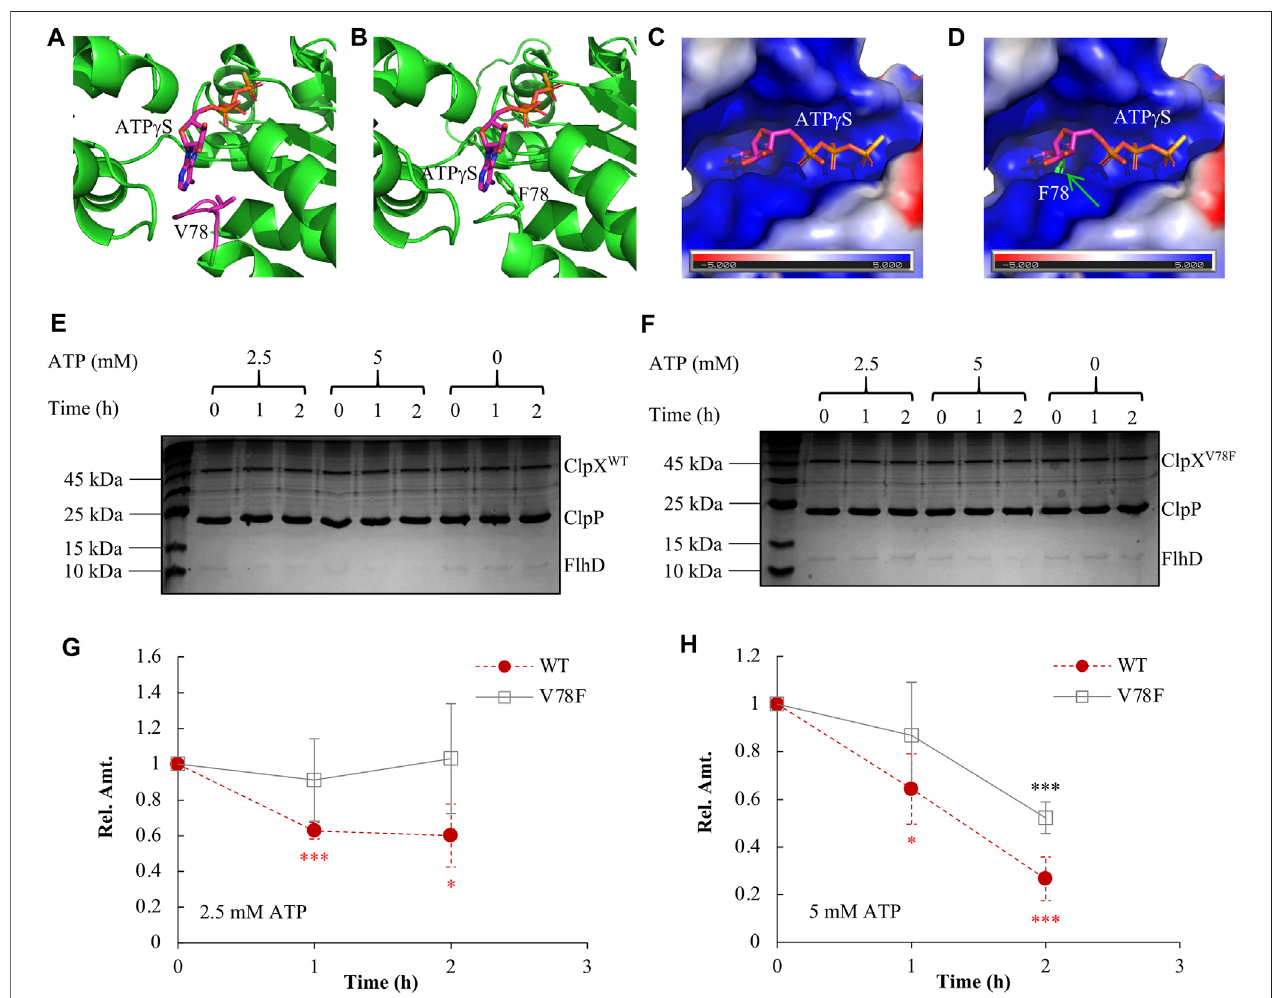
FIGURE 4| Elucidating the molecular mechanism of FlhDC accumulation mediated byClpX V78F . (A) The 3D structure of the wild-type ClpX interactingwith ATP γ S (PDB code 4I81). (B) The modeled 3D structure ofthe ClpX V78F interacts with ATP γ S. In (A) and (B) , ATP γ Sand V78/F78 are rendered as sticks whileall other parts are shown as cartoon. The interaction mode between ATP γ S and the ClpX V78F is modeled by superposing the C α atoms of ClpX V78F to those of wild-type ClpX (chain A of PDB code 4I81). (C) The molecular surface representation of the ATP-binding pocket of wild-type ClpX. The surface is colored according to the electrostatic potential calculated using the APBS tool (Baker et al., 2001; Dolinsky et al., 2004) in PyMOL, where blue and red colors, respectively, indicate positive and negative potential. The electrostatic potential of the binding pocket is mainly positive, which is complementary to the negative charge of ATP especially in the three phosphate groups. (D) Themolecularsurfaceofthewild-typeClpXsuperposedwithClpX V78F .TheF78ofClpX V78F isrenderedassticks,anditprotrudesfromthemolecularsurface ofthewild-typeClpXintroducingasterichindranceeffectatthebindingpocketofATP γ S. (E) The invitro degradationassaywithClpX WT PforFlhD.Asindicated,aproper amountofClpX WT (2 μ M),ClpP(4.3 μ M),andFlhD(0.65 μ M)wasincubatedtogetheratthepresenceof0,2.5,or5 mMATP.Thereactionmixobtainedattime0,1,and 2 h was checked using SDS-PAGE electrophoresis followed by Coomassie-brilliant-blue staining. The shown result is a representative of three independent experiments. (F) The in vitro degradation assay with ClpX V78F P for FlhD. The assay was performed as described above in Figure 4E , except using ClpX V78F (2 μ M) instead of ClpX WT (2 μ M). The shown result is a representative of three independent experiments. (G – H) FlhD quanti fi cation during the process of in vitro degradation at thepresenceof2.5 mM (G) or5 mM (H) ATP.TheproteinbandsofFlhDinpanels (E) and (F) werequanti fi edusingthesoftware ImageJ.Theamount ofFlhDattime 0 h wasset as 1, and thatat other time points was determined relative tothis value. FlhD degradation at the presence of0 mM ATP was used asa control for normalization. The FlhDrelative amount (Rel. Amt.) isshown astheaverage ± S.E.M. ofthe threeindependentexperiments. * p ≤ 0.1, *** p ≤ 0.01 versus theFlhDrelative amountat time 0 h in the reaction with ClpX WT (red) or that in the reaction with ClpX V78F (black).